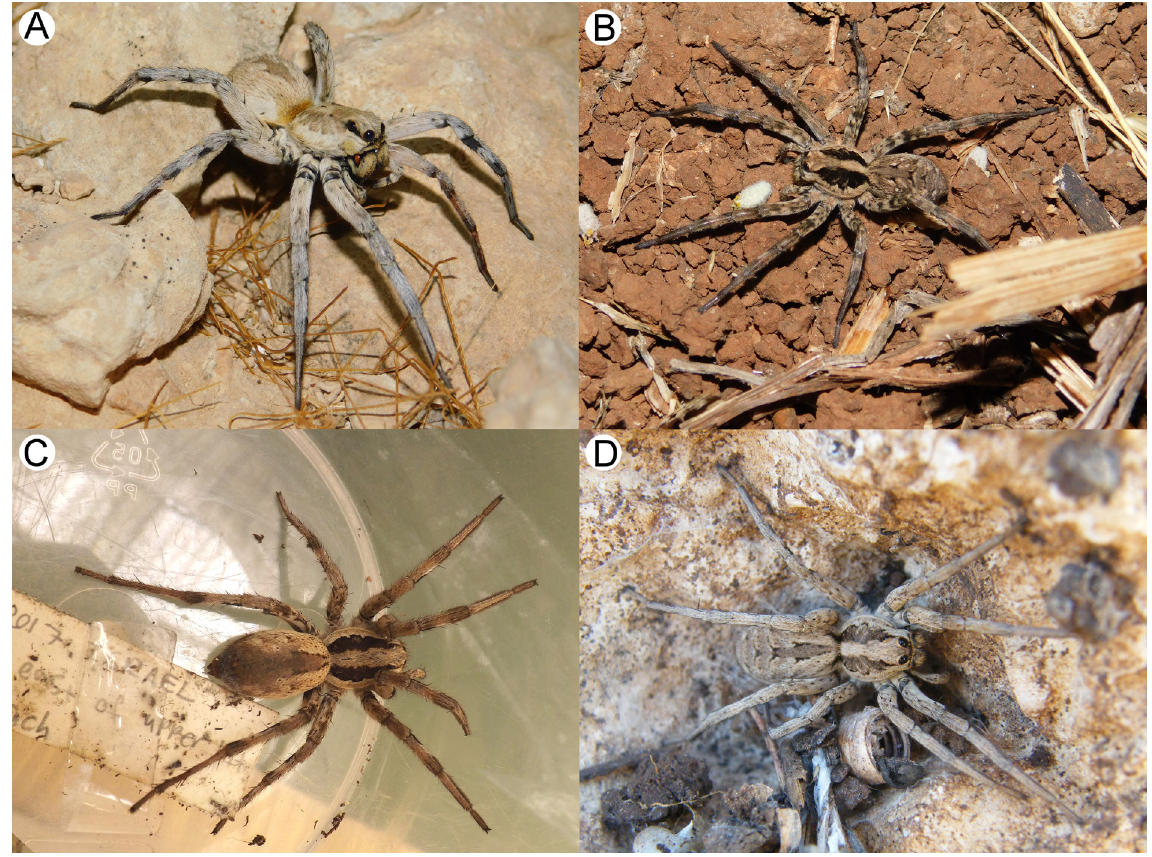
Fig. 17. Lycosa piochardi Simon, 1876, live females demonstrating common dorsal coloration morphs. A . Sandy morph, Midreshet Ben-Gurion. B . Dark brown morph, Mt. Gilboa. C . Light brown with dark brown median bands, Mt. Hermon. D . Light brown morph, Modi’in. Photos by I. Armiach